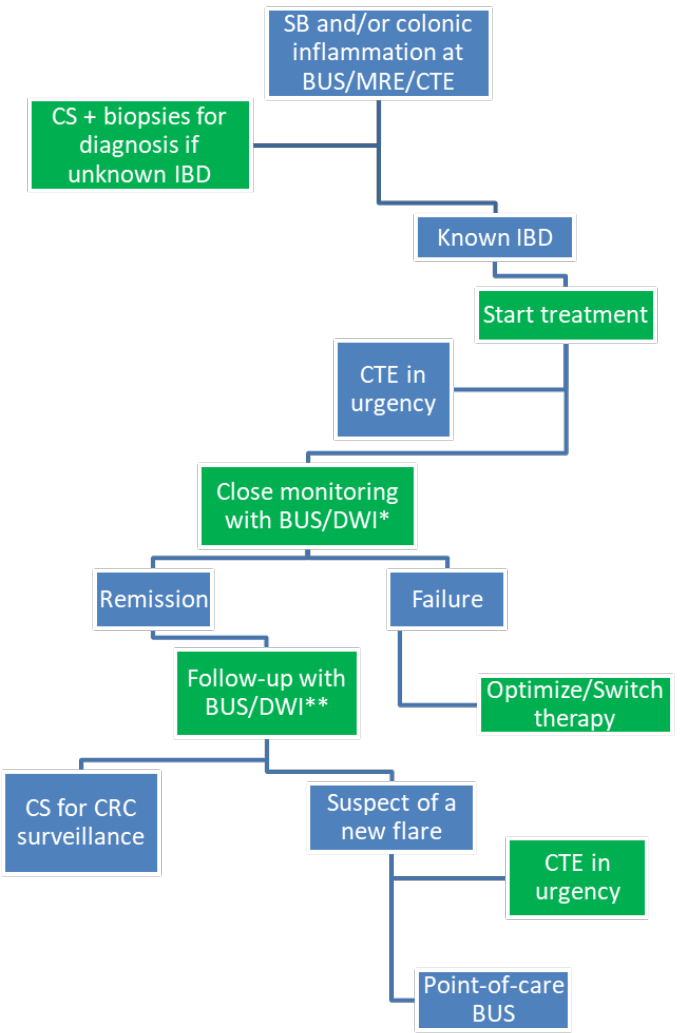
Figure 1. Proposed flowchart for the use of cross-sectional imaging techniques for monitoring of inflammatory bowel disease (IBD). * Every three months for active disease. ** Every six to twelve months in clinical and biochemical remission. BUS, bowel ultrasound; MRE, magnetic resonance enterography; CTE, computed tomography enterography; CS, colonoscopy; DWI, diffusion weighted imaging; CRC, colorectal